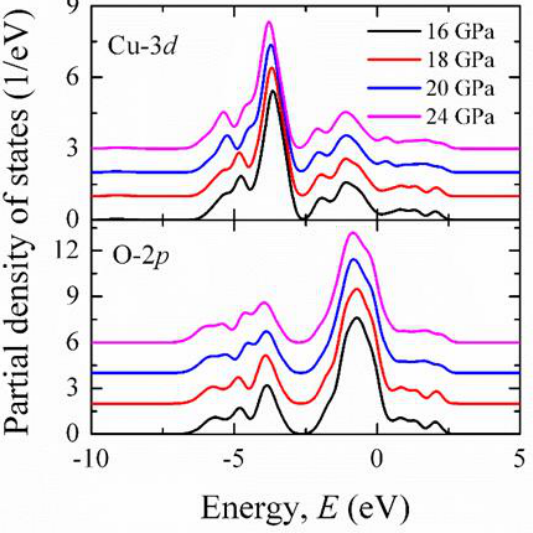
Figure 14. The energy dependence of the ( a ) real and ( b ) imaginary part of the dielectric constant of BaCuO 3 at some selected pressures. Different offset values are set to visualize the optical spectra clearly.